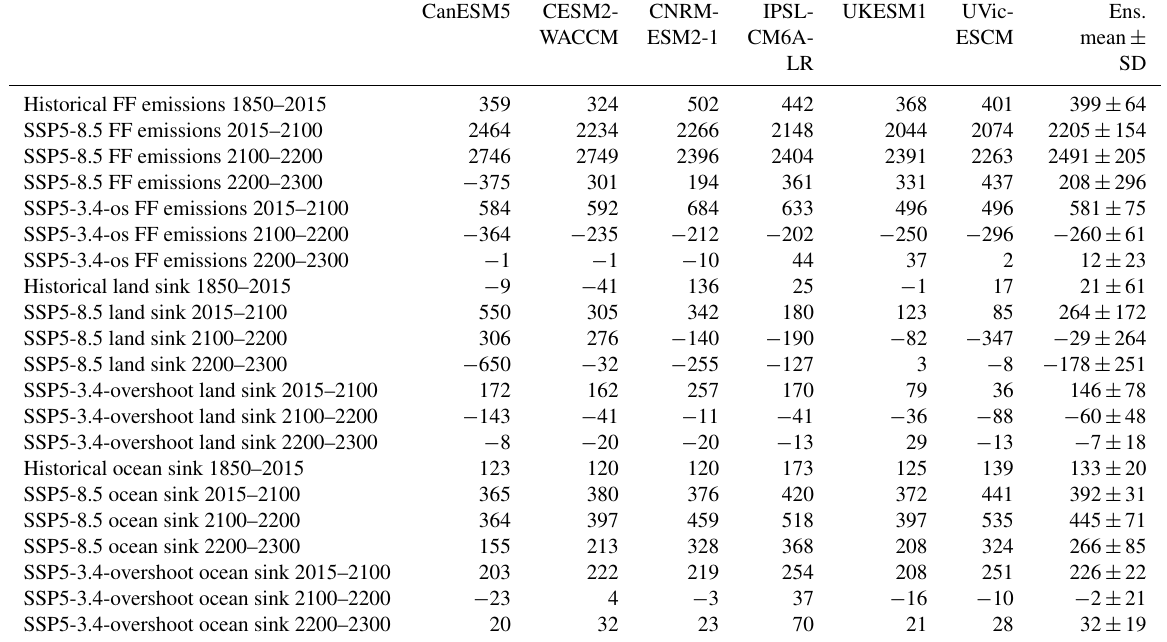
Table B1. Cumulative fluxes by model, scenario, and time period. All fluxes are in PgC.